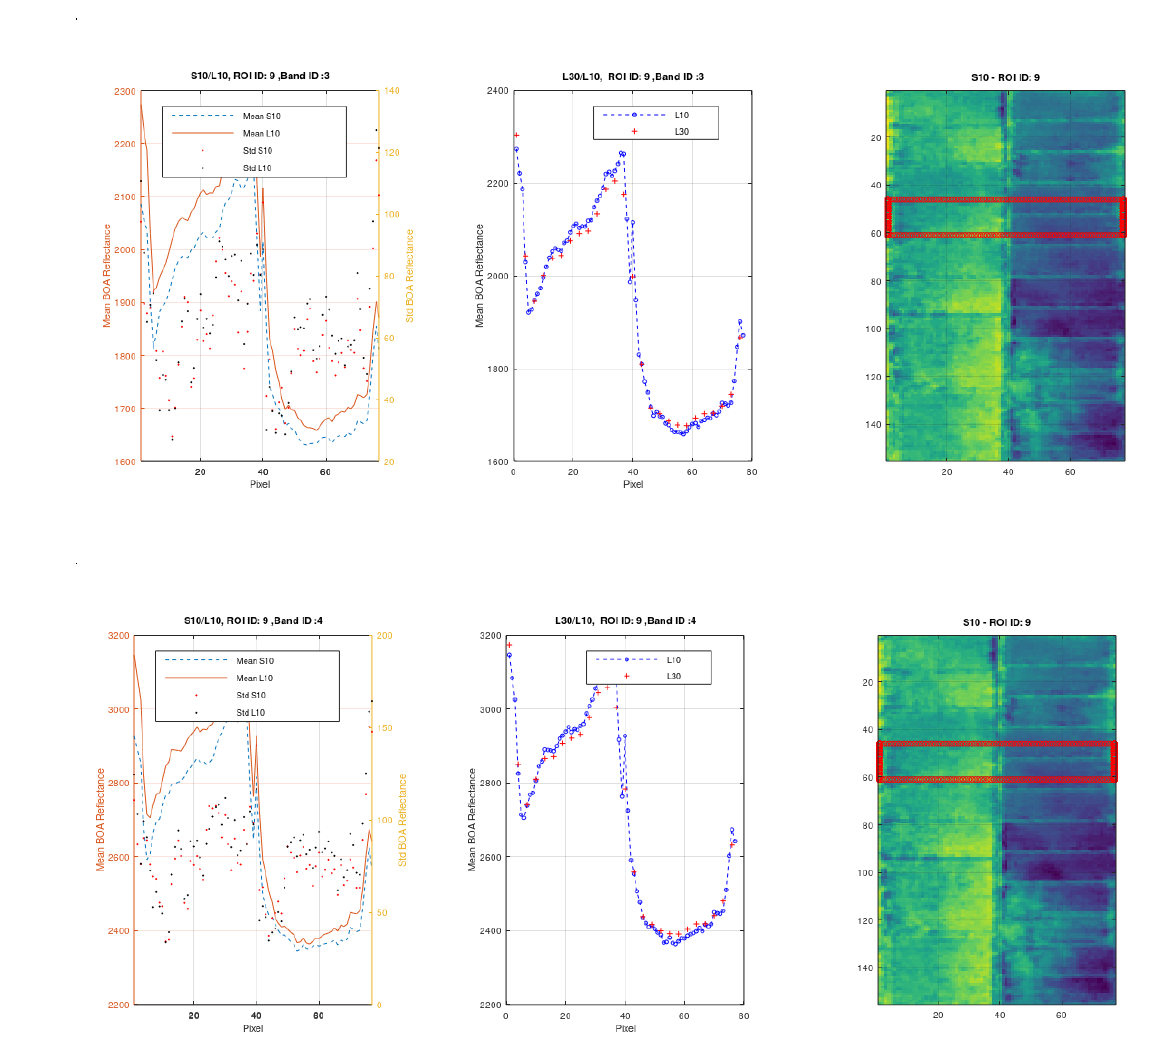
Figure A3. B02, B03, B04 images of ROI 9 ( right ) overplayed with image area (red box) used to compute mean edge profile in pixel direction (12SVB MGRS tile). For each band, the LS8 L2H/LS8 L2F plot ( middle ) confirms agreement between values, and S2 L2F/LS8 L2F ( left ) confirms that the synthetic LS8 L2F mean edge profile matches the S2 L2F mean edge profile. Greater error (<0.02 BOA) is observed for B02, which might be due to the inter-calibration between the two sensors.